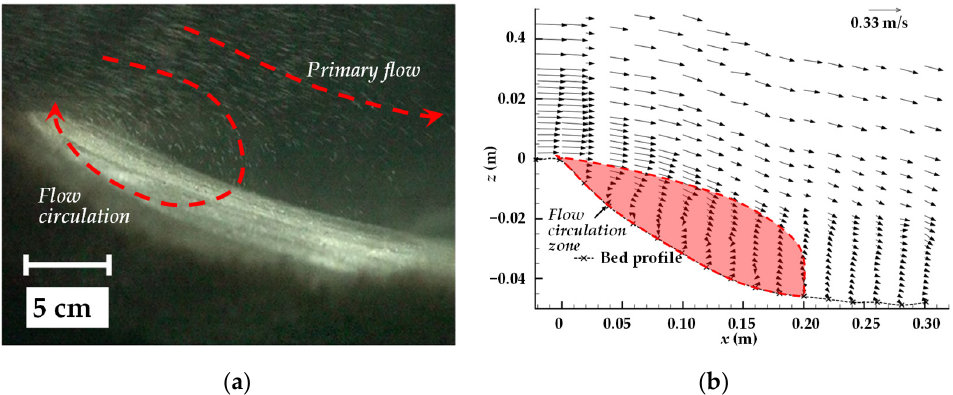
Figure 4. Flow patterns in the upstream scour hole of the equilibrium state (modified from [18]). ( a ) Snapshot of particle movement and ( b ) vertical velocity vector profile.